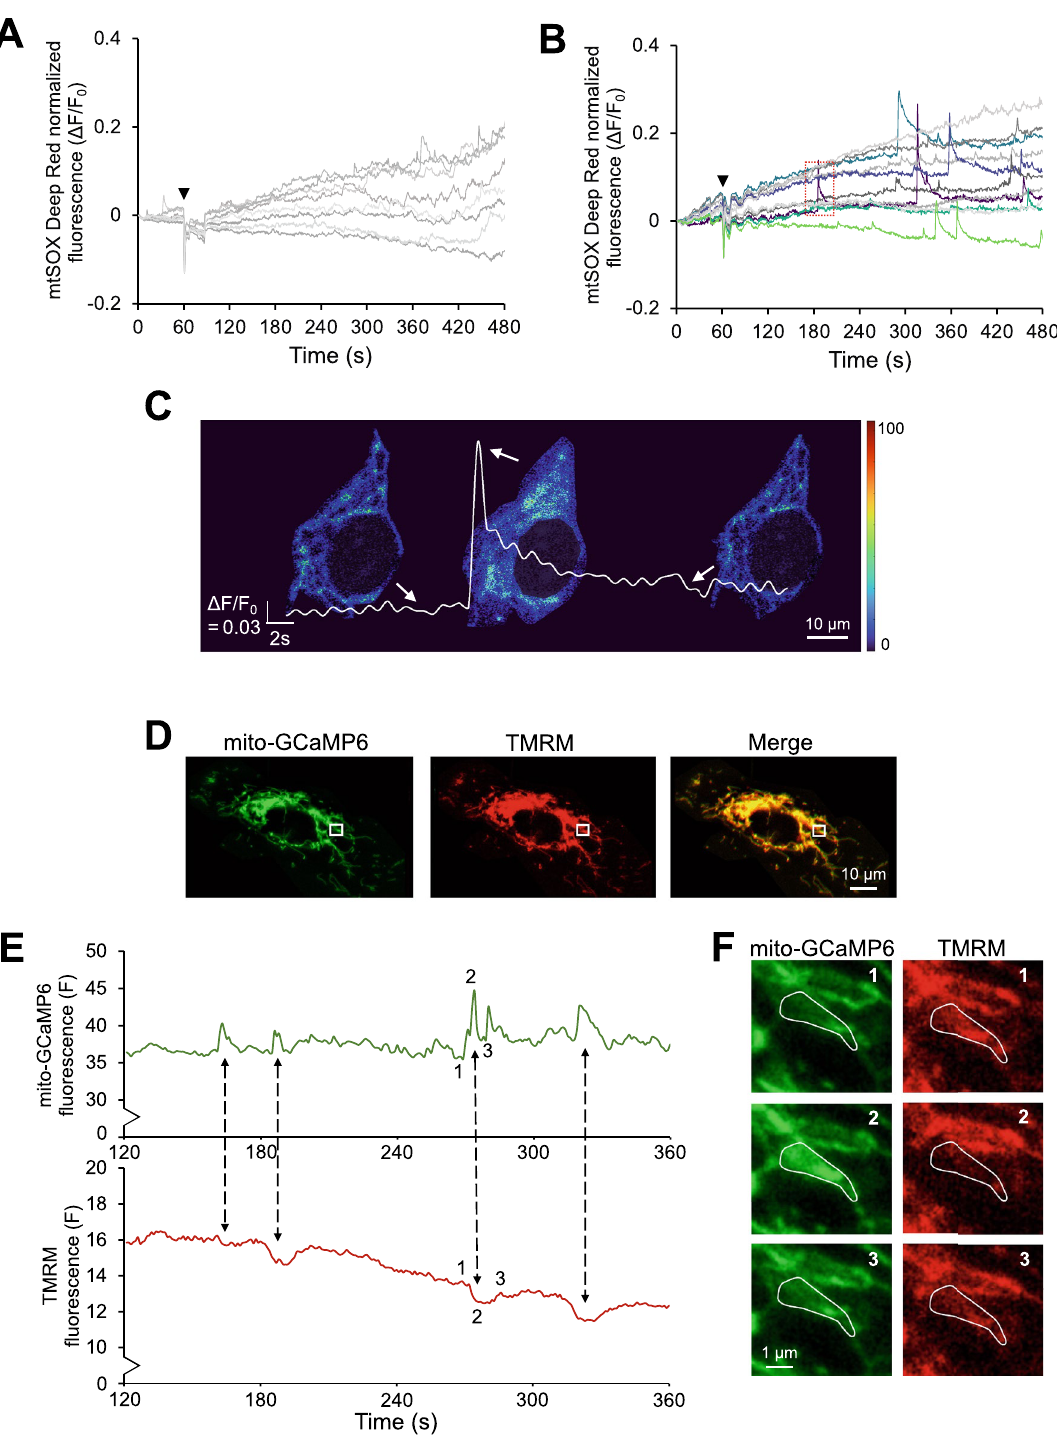
Figure 3. MCU OX causes mROS flashes and ΔΨ m flickers in sheared ECs. ( A ) Characteristic temporal profiles of normalized mtSOX Deep Red fluorescence for each EC in a microscope image, where the monolayer was exposed to 1 min static followed by 9 min SS. ( B ) Same as in ( A ), but for Ad.MCU-transduced ECs. ( C ) Magnification of a ΔΨ m transient (shown by a dotted box in B ). ( D ) Characteristic TMRM fluorescence shows overlap with mito-GCaMP6 in an unstimulated EC. ( E ) F (in arbitrary units) averaged over an area of a cell (white box in D ) for both mito-GCaMP6 and TMRM vs. time. ( F ) Magnification of the cell area (white box in D ) shows opposing behavior between mito-GCaMP6 and TMRM at a single-mitochondrion level at time points 1–3 (time points shown in E